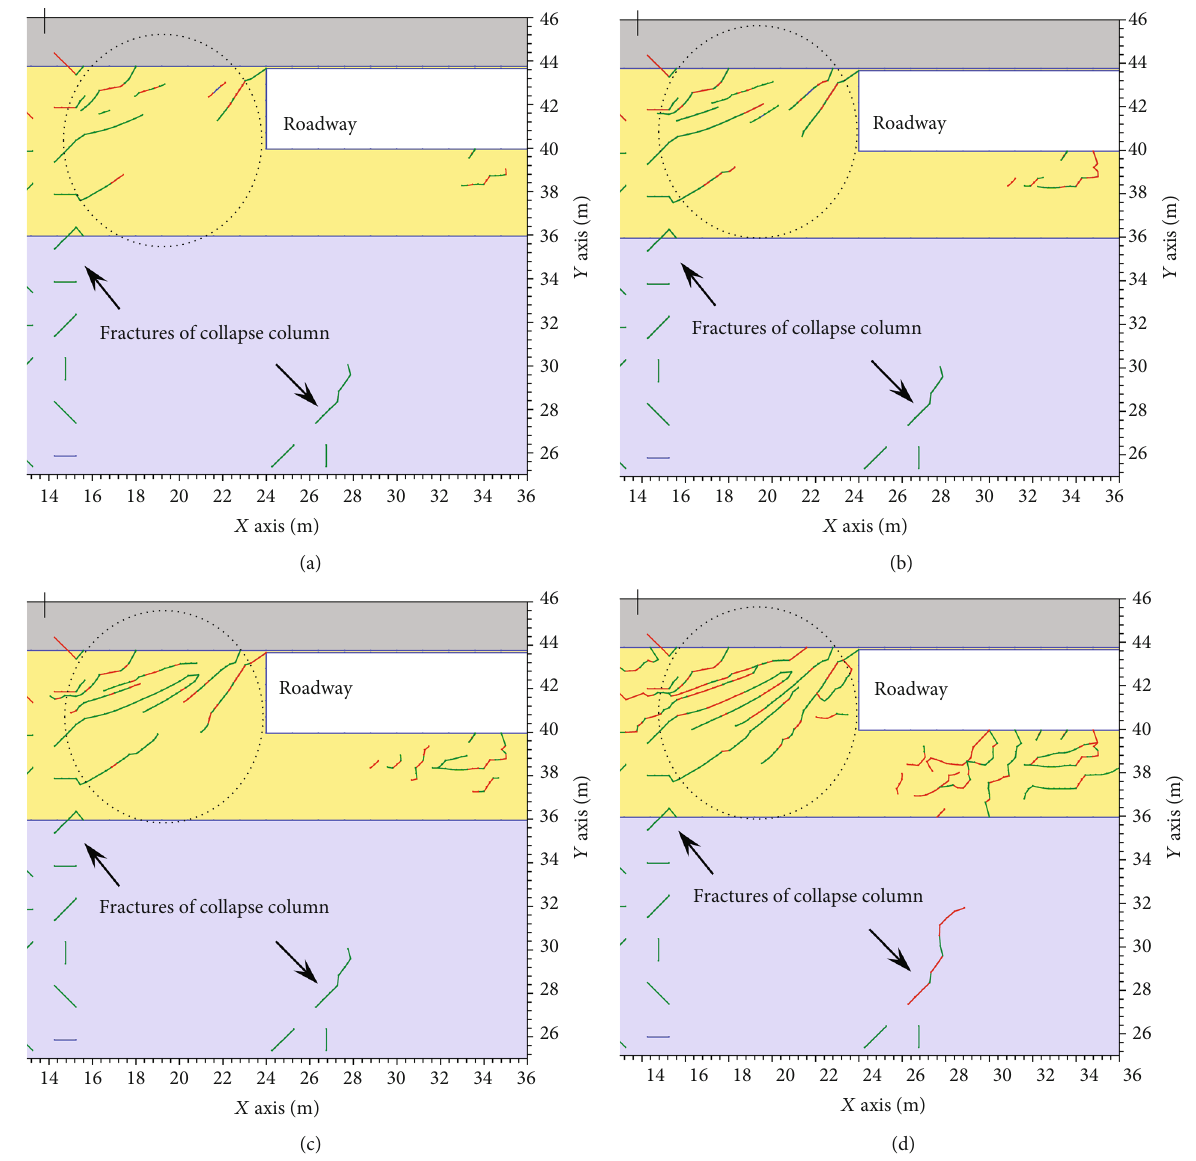
Figure 12: Modelled fracture initiation, propagation, and coalescence in the coal pillar and rock mass surrounding the roadway cavern: (a) cycle 9, (b) cycle 12, (c) cycle 14, and (d) cycle